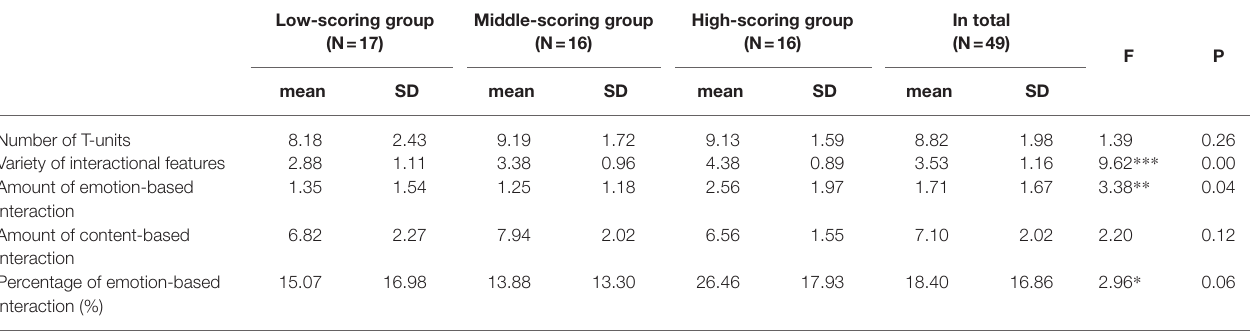
Low-scoring group (N = 17)